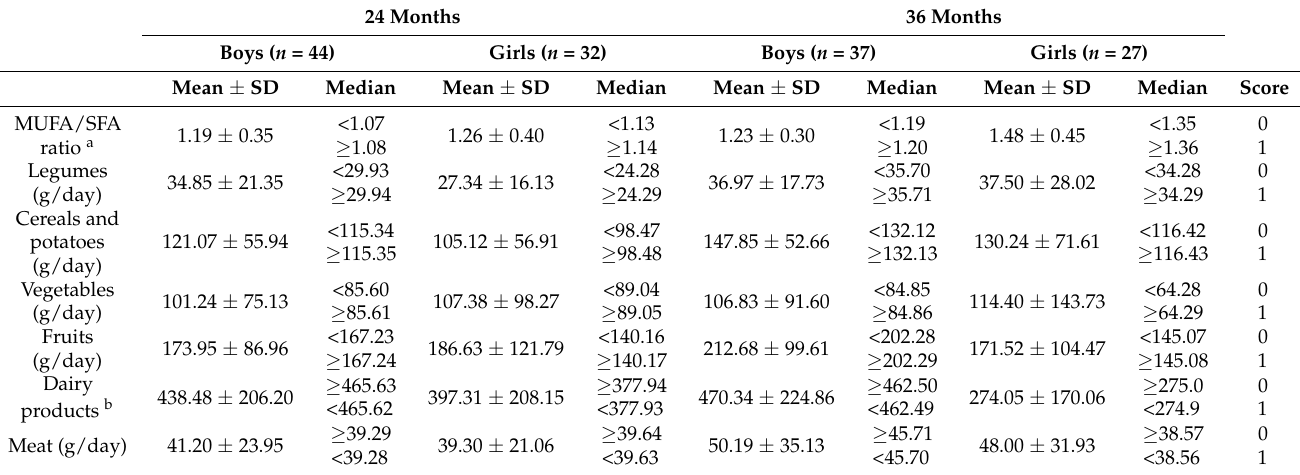
Table 1. Mediterranean Diet Score calculation by age group and gender.